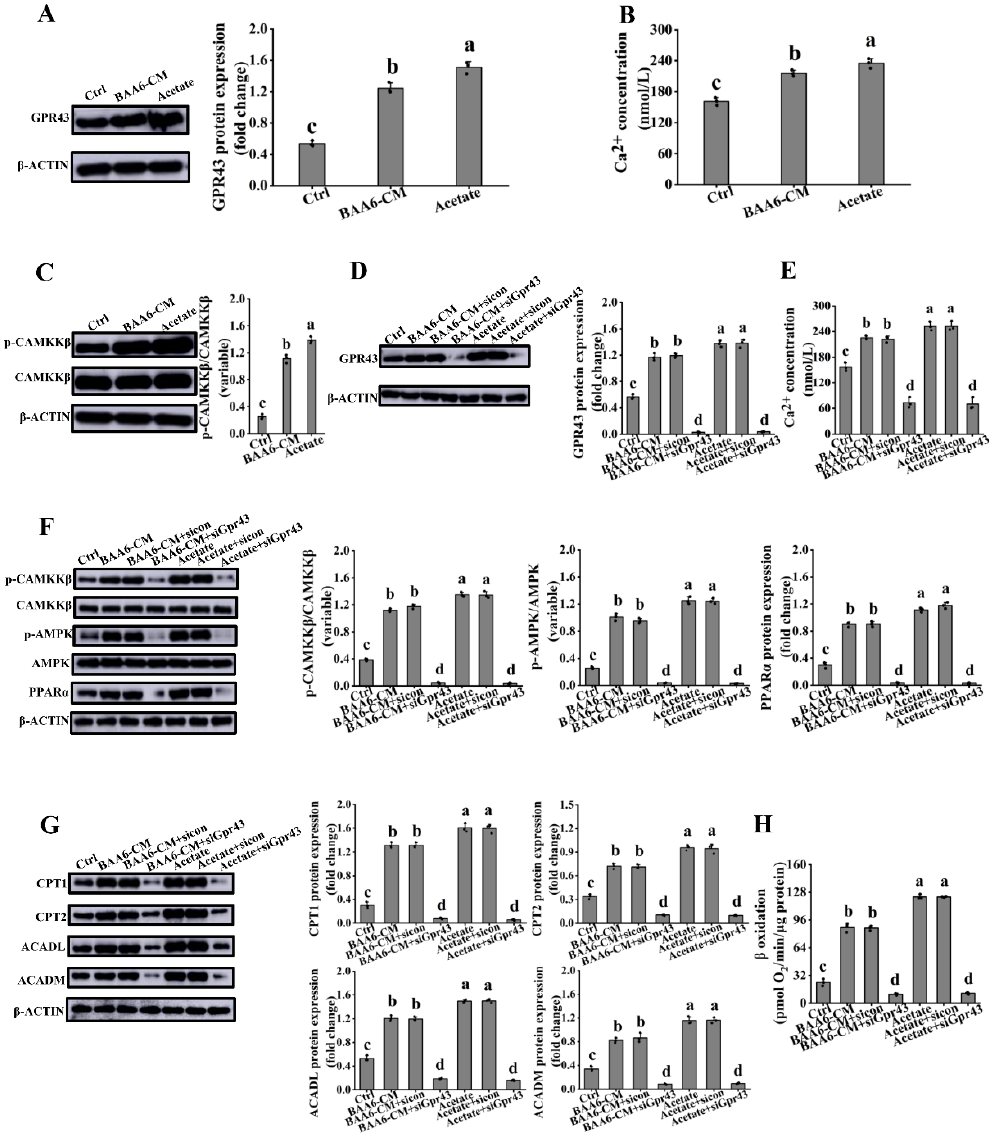
Figure 7. Effect of acetate or BAA6-CM on GPR43 signaling in 3T3-L1 cells. Western blot analysis showing the levels of ( A ) GPR43, ( B ) Ca 2+ contents, and ( C ) p-CAMKKβ in 3T3-L1 cells after treatment with 4% BAA6-CM or 23.96 mmol/L acetate for 3 days. Protein expression levels of ( D ) GPR43 and ( E ) Ca 2+ concentration, after the cell is treated with control or GPR43-special siRNA, followed by addition of 4% BAA6-CM or 23.96 mmol/L acetate for 3 days. ( F ) Protein expression levels of p-